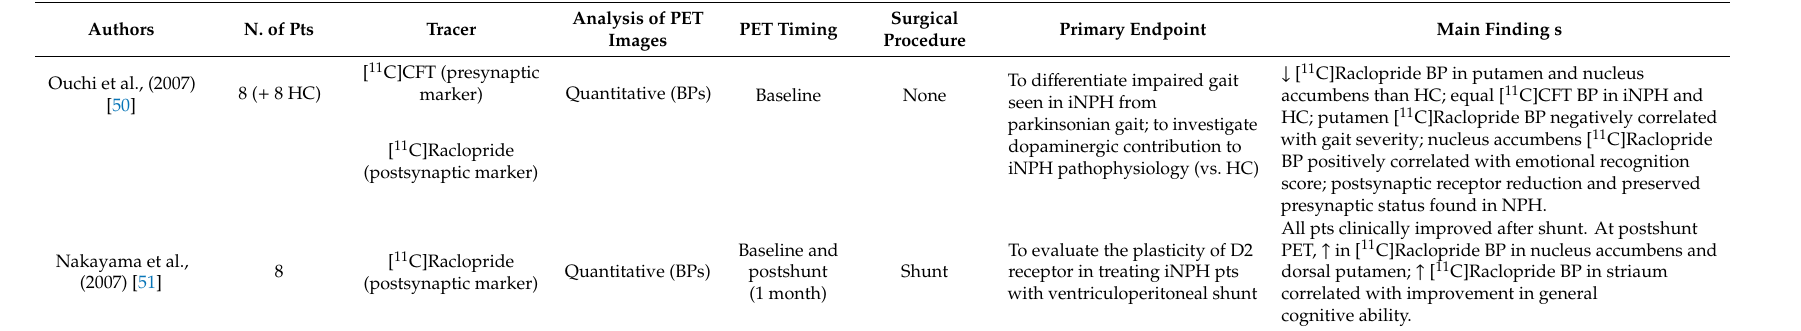
Table 4. Dopaminergic PET imaging in NPH